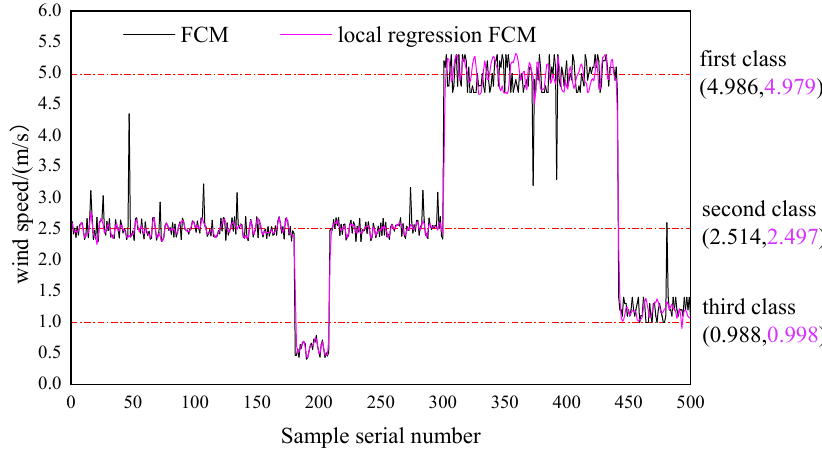
Figure 6. Comparison of the clustering centers of the two methods.